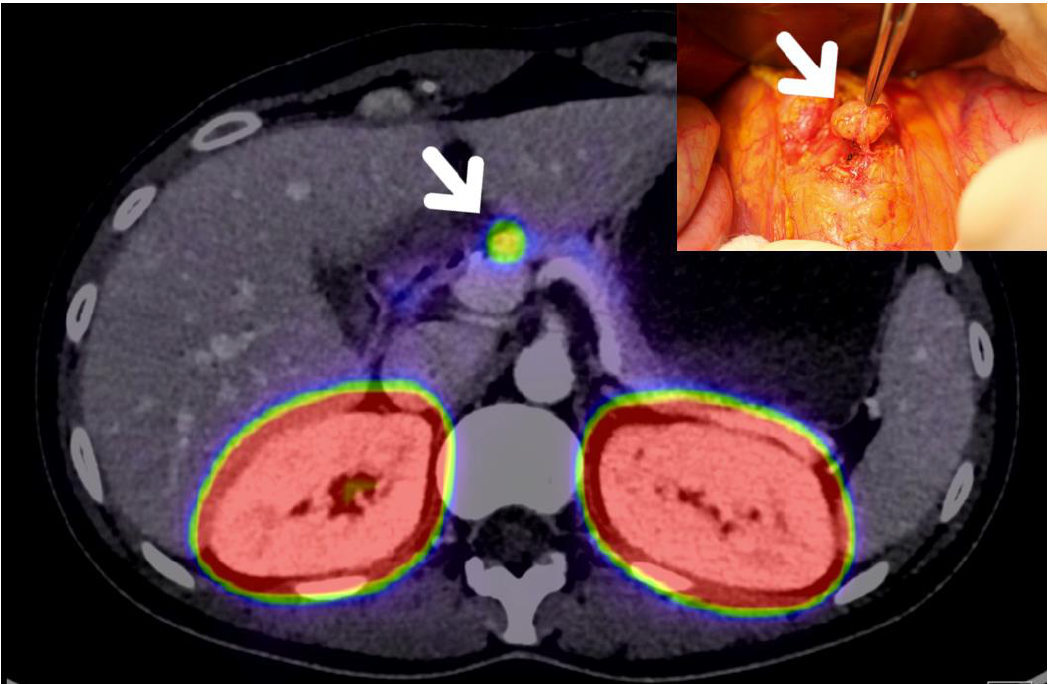
Figure 3. Glucagon-like peptide-1 receptor (GLP-1R) PET/CT locating a 7 mm insulinoma, latter enucleated.